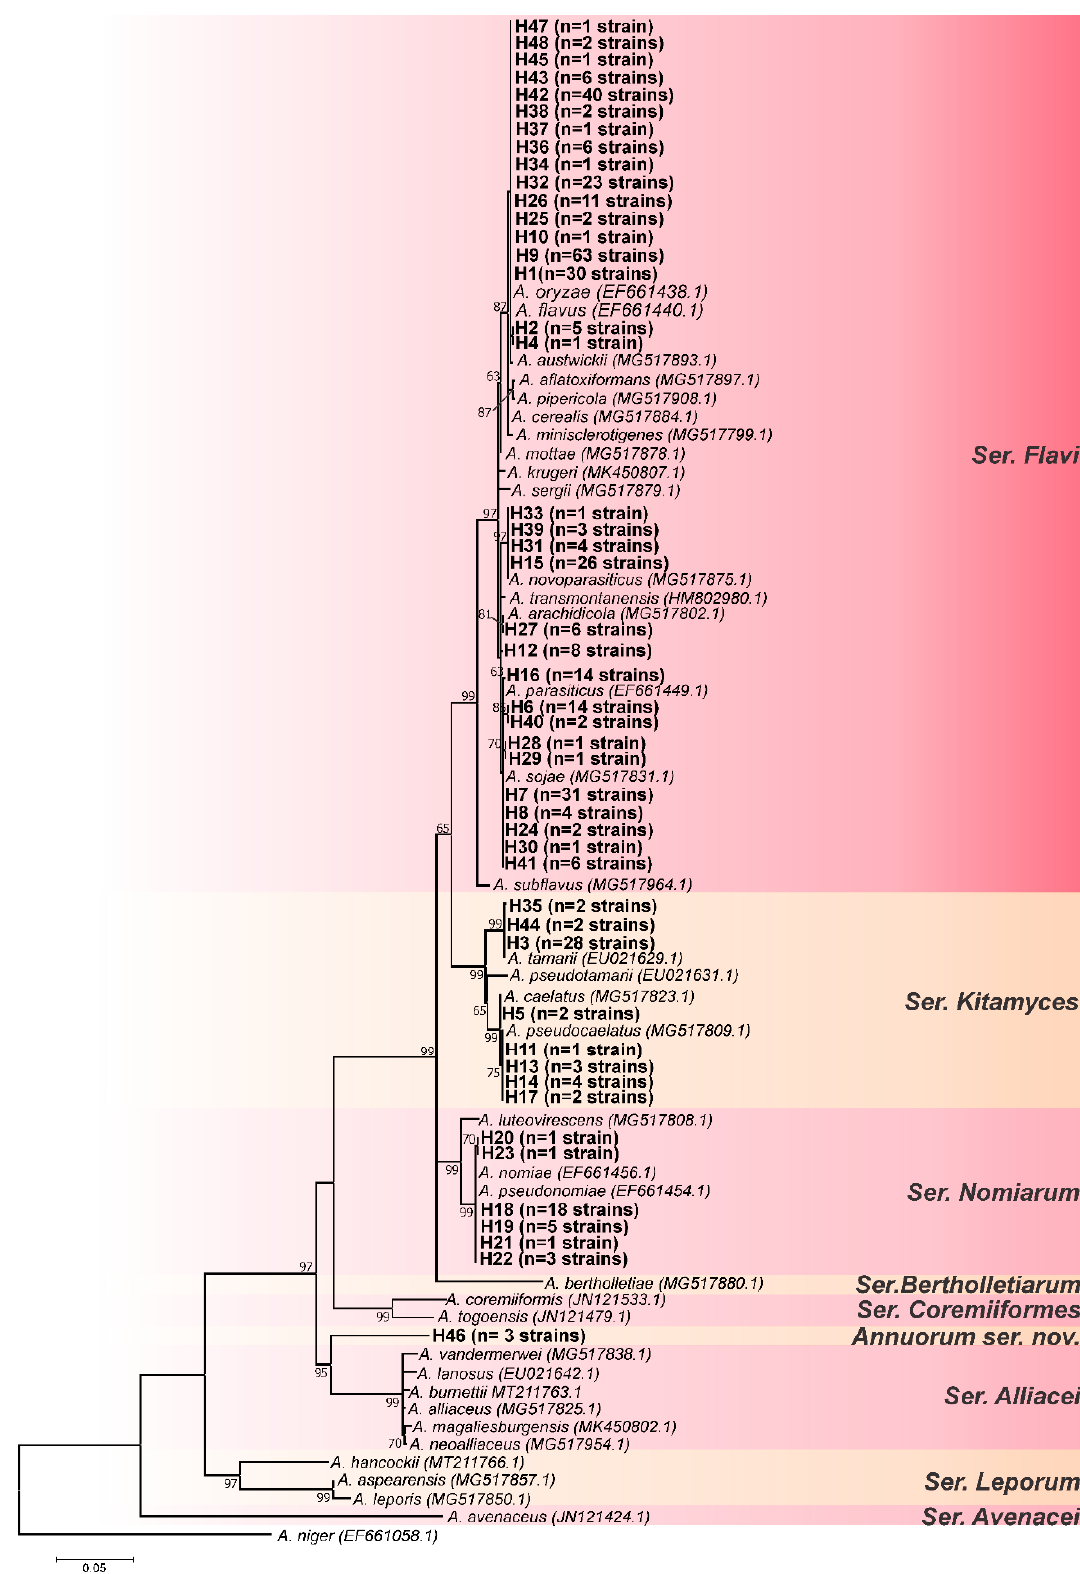
Figure 3. Maximum-likelihood tree of Aspergillus section Flavi based on RPB2 sequences. Haplotypes obtained in this study are indicated by the letter H in bold. Only bootstraps ≥ 60% are shown. Aspergillus niger is the outgroup.